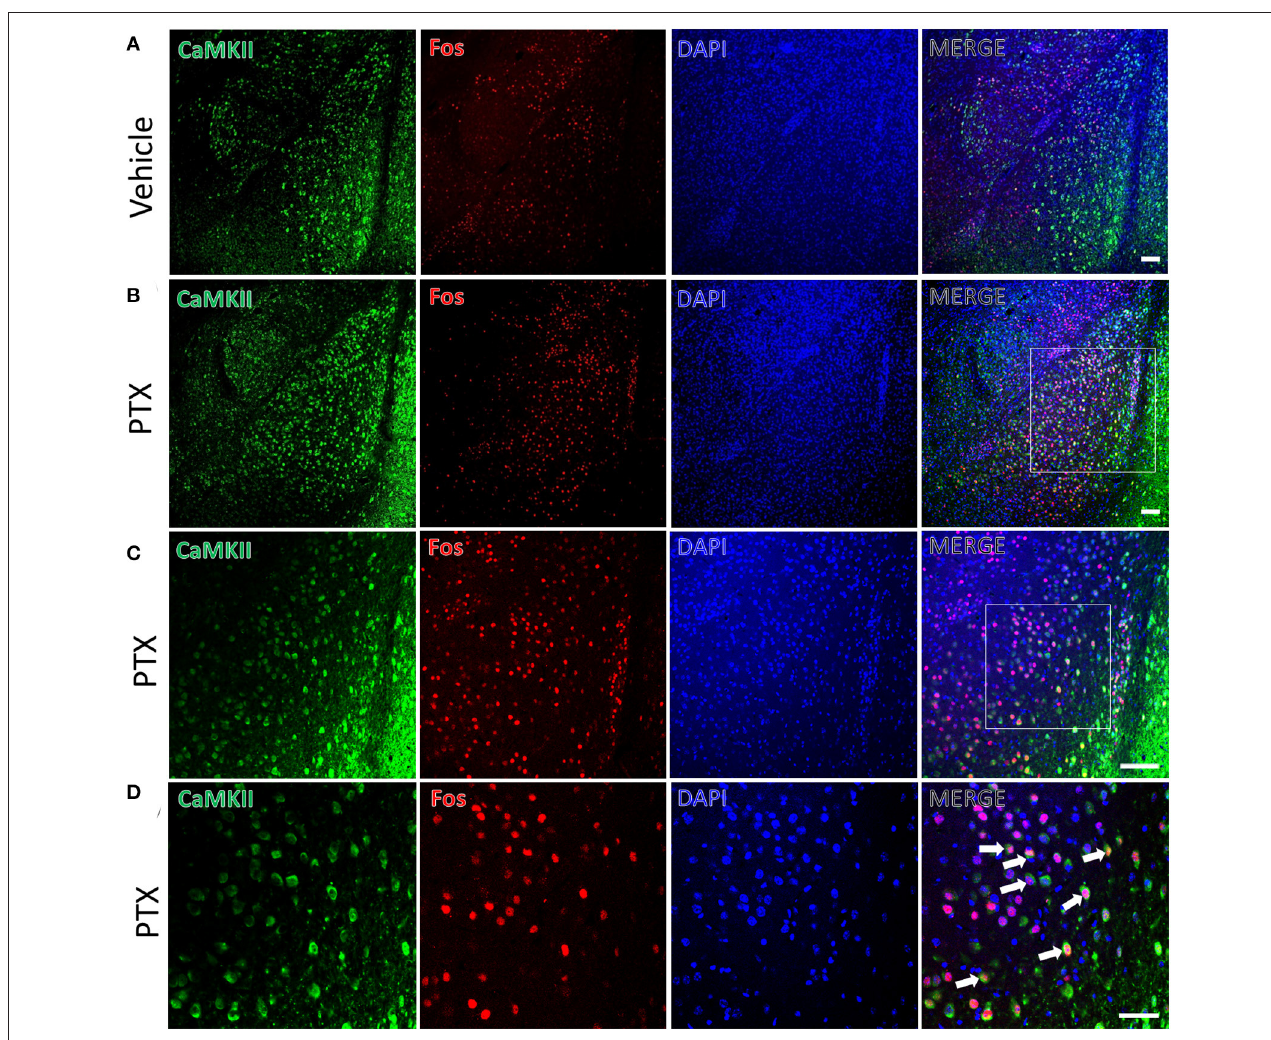
FIGURE 2 | CaMKII neurons in the BLA are activated in paclitaxel-treated mice. (A) The expression of CaMKII (green) and Fos (red) in the BLA of the vehicle group. (B,C) The expression of CaMKII (green) and Fos (red) in the BLA of the paclitaxel group under different multiples microscope. (D) The magnified images of the rectangles indicated in (C) . Arrows indicate part of CaMKII and Fos double-labeled neurons. n = 3 mice per group, 2 sections per mouse. Scale bars = 100 µ m in (A) [applies to (B,C) ]; 50 µ m in (D)